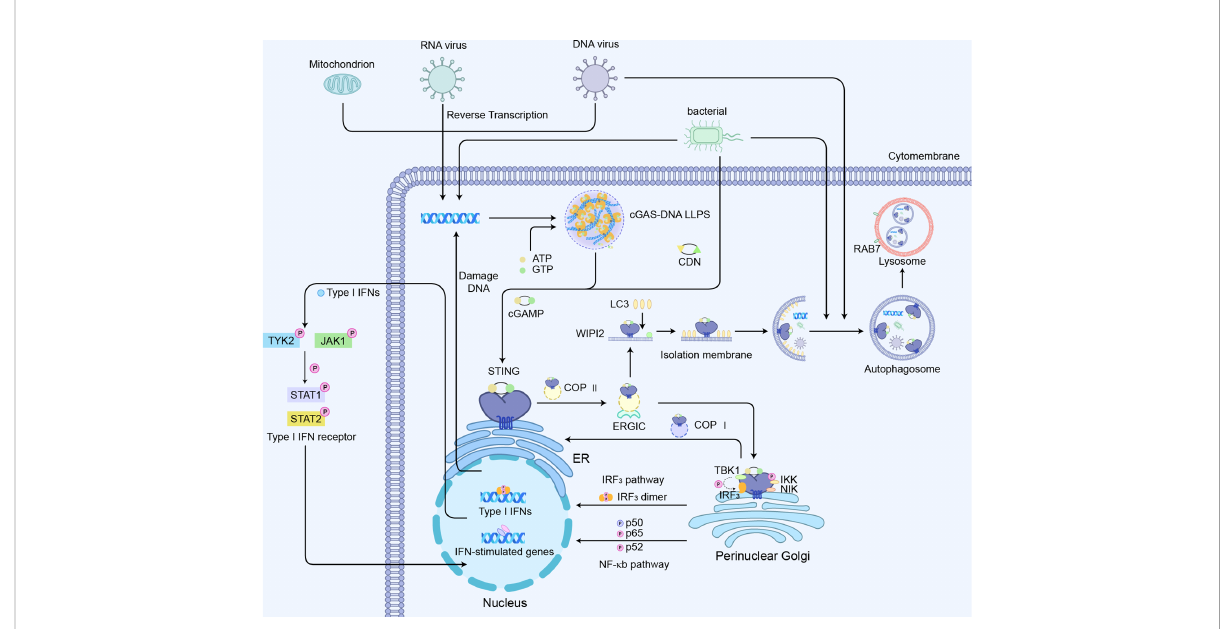
FIGURE 4 cGAS-STING-mediated signaling pathways:1) cGAS-STING-IRF 3 pathway; 2) cGAS-STING mediated NF- k b pathway activation; 3) cGAS -STING induced autophagy